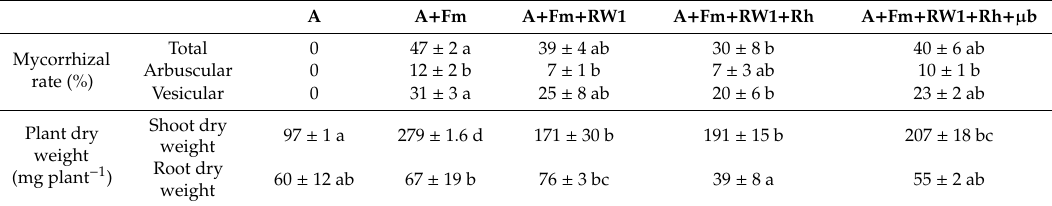
Table 3. Total, arbuscular, and vesicular mycorrhizal colonization of alfalfa in response to di ff erent conditions. Conditions consisted of non-inoculated alfalfa (A), combined with F. mosseae (A +